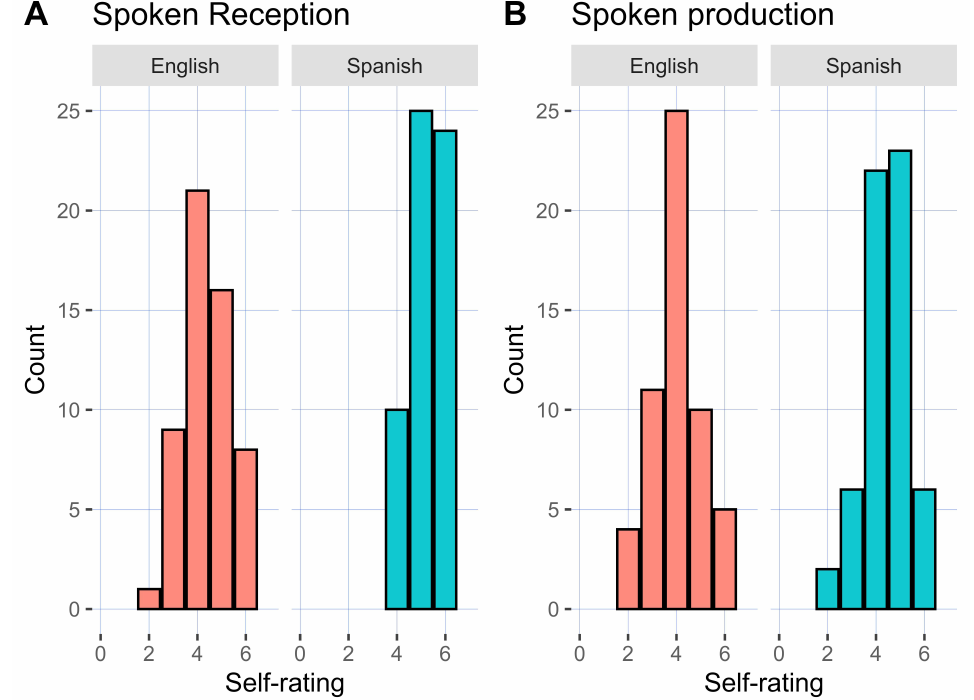
Figure 2. Self-rated L2 Proficiency. The top panels refer to the L1 of the participant and the ratings refer to their L2 ( A ) Self-rated spoken perception ( B ) Self-reported spoken